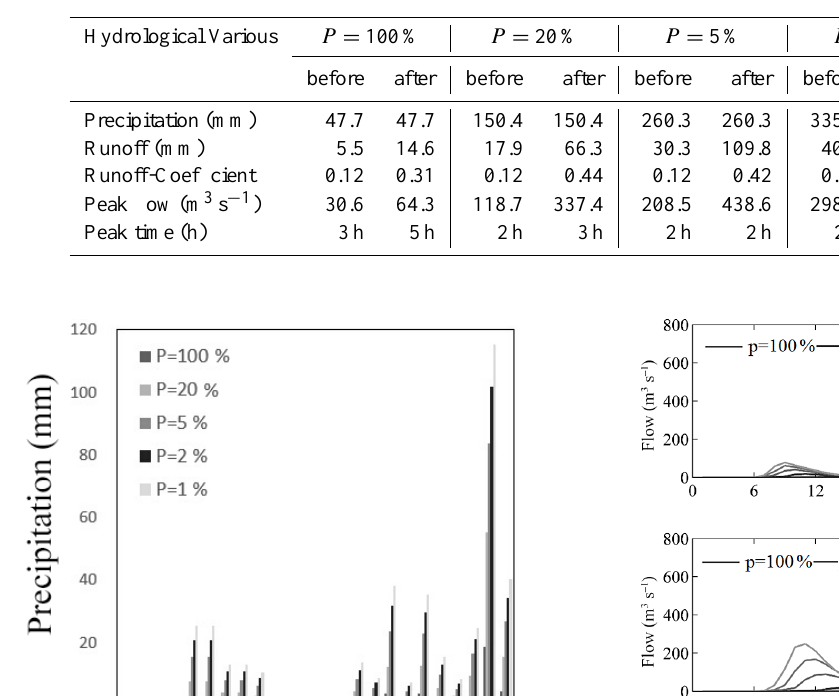
Table 3. Changes of rainfall-runoff processes in different scenarios.